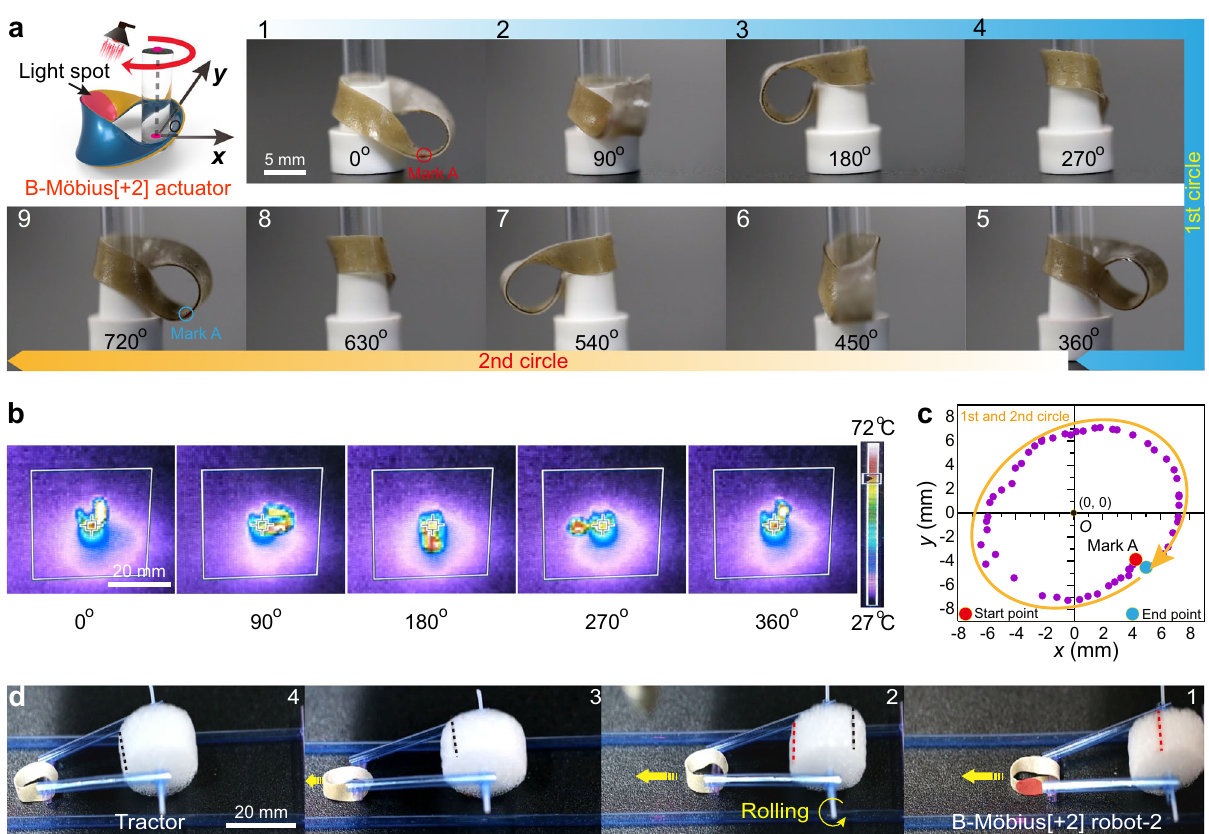
Fig. 4 NIR light-guided clockwise rotation of the B-Möbius[ + 2] actuator. a Photographs of continuous clockwise rotation of one B-Möbius[ + 2] actuator around a circular cylinder under irradiation by NIR light (scale bar: 5 mm). Supplementary Movie 3 shows the scenario in motion. b Real-time temperature distribution in the B-Möbius[ + 2] ribbon during clockwise rotation. The colour bar represents the real-time object temperature (scale bar: 20 mm). c Position coordinates of the point denoted mark A on the B-Möbius[ + 2] ribbon recorded during a continuous 720° clockwise rotation. d Photographs of a light-fuelled B-Möbius[ + 2] tractor dragging a foamy cylinder (scale bar: 20 mm). Supplementary Movie 9 shows the scenario in strip under NIR light stimulation of a position near the twist region of the B-Möbius[±2] actuator (Supplementary Fig. 7 and Supplementary Movie 8).